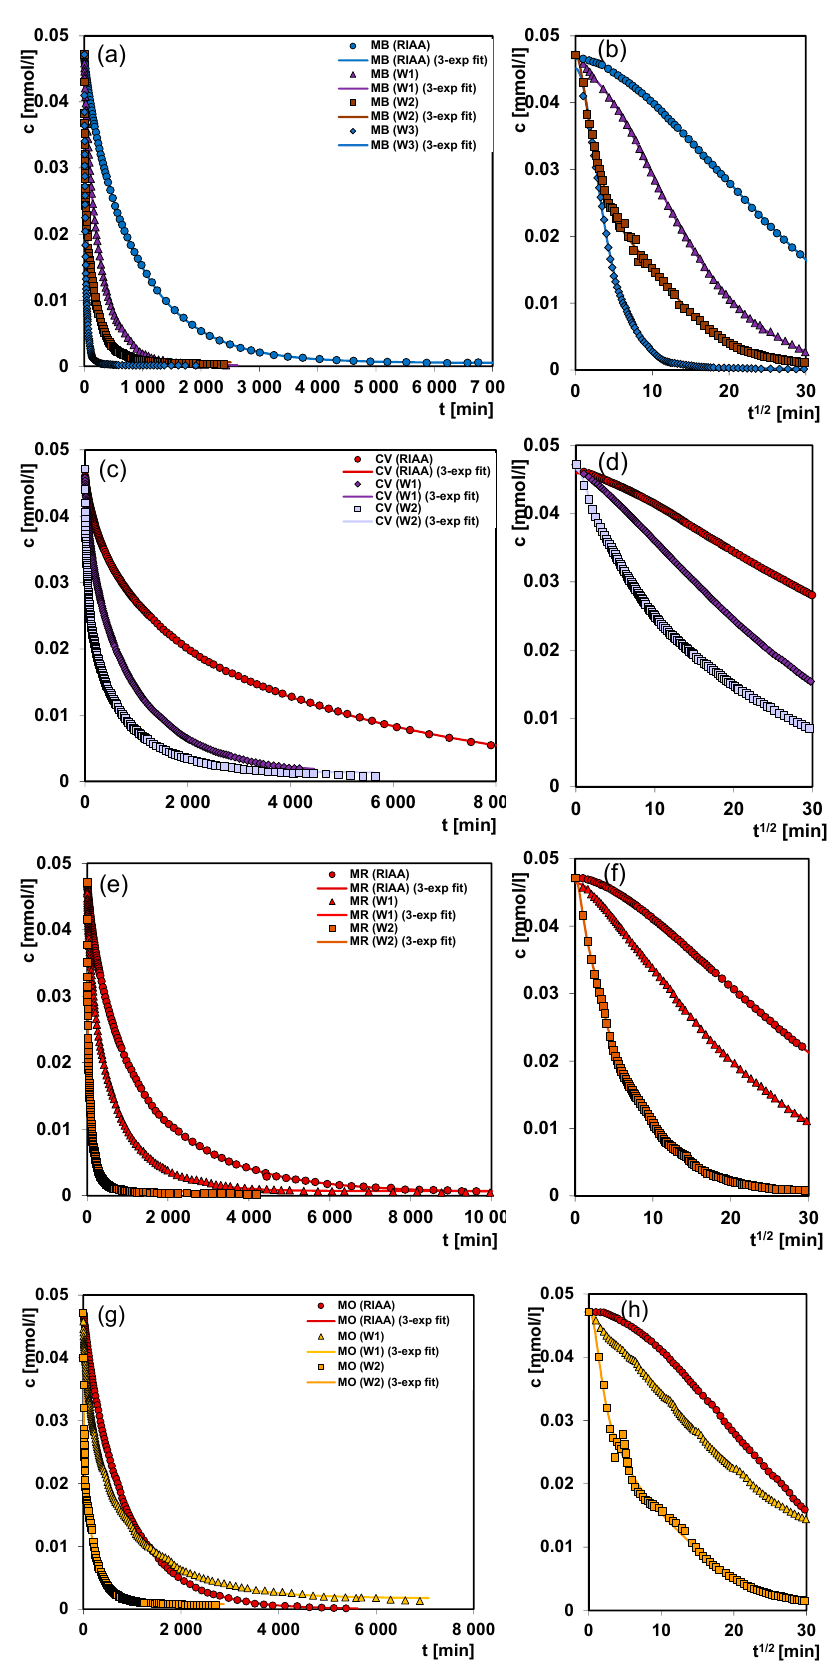
Figure 10. Comparison of adsorption kinetics of methylene blue ( a , b ); crystal violet ( c , d ); methyl red ( e,f ) and methyl orange ( g , h ) on the activated carbons at the coordinates: relative concentration ~ time and relative concentration ~ square root of time.